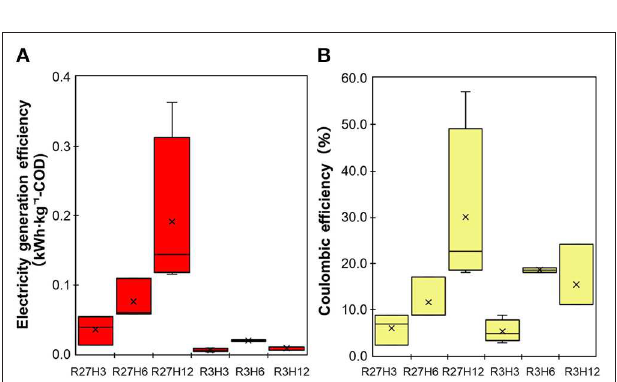
FIGURE 5 | The electricity generation efficiency (A) and Coulombic efficiency (B) for the MFCs operated under 6 different